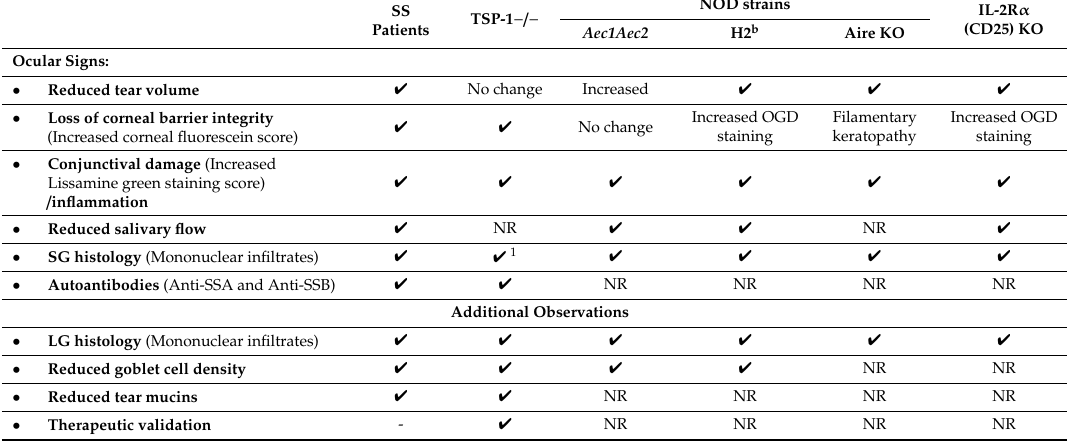
Table 1. Objective tests used in SS diagnosis and observations related ocular surface disease in patients and animal